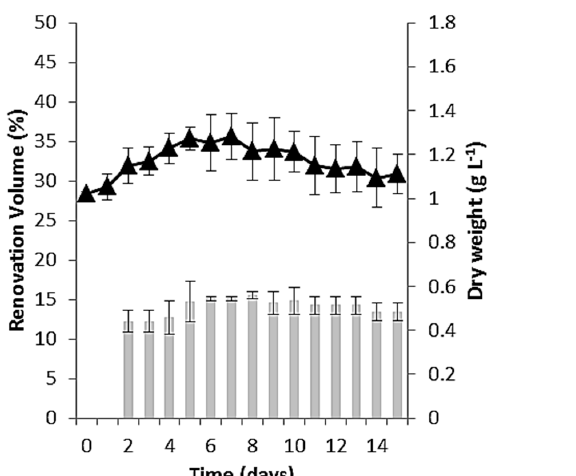
Figure 3. Growth of Nannochloropsis oceanica in 2.6 m 3 tubular PBRs using three different operation regimes: batch, semi-continuous and continuous. The values presented are the average of the three independent biological replicates, and the error bars are the respective standard deviations. The black arrow represents the day in which the continuous regimes started to be diluted, and the white arrows represent the moments of medium renewals under the semi-continuous regime. The semi-continuous culture was renewed every second day, beginning on the 3rd day and was renovated five more times during each trial. The water volumes spent in